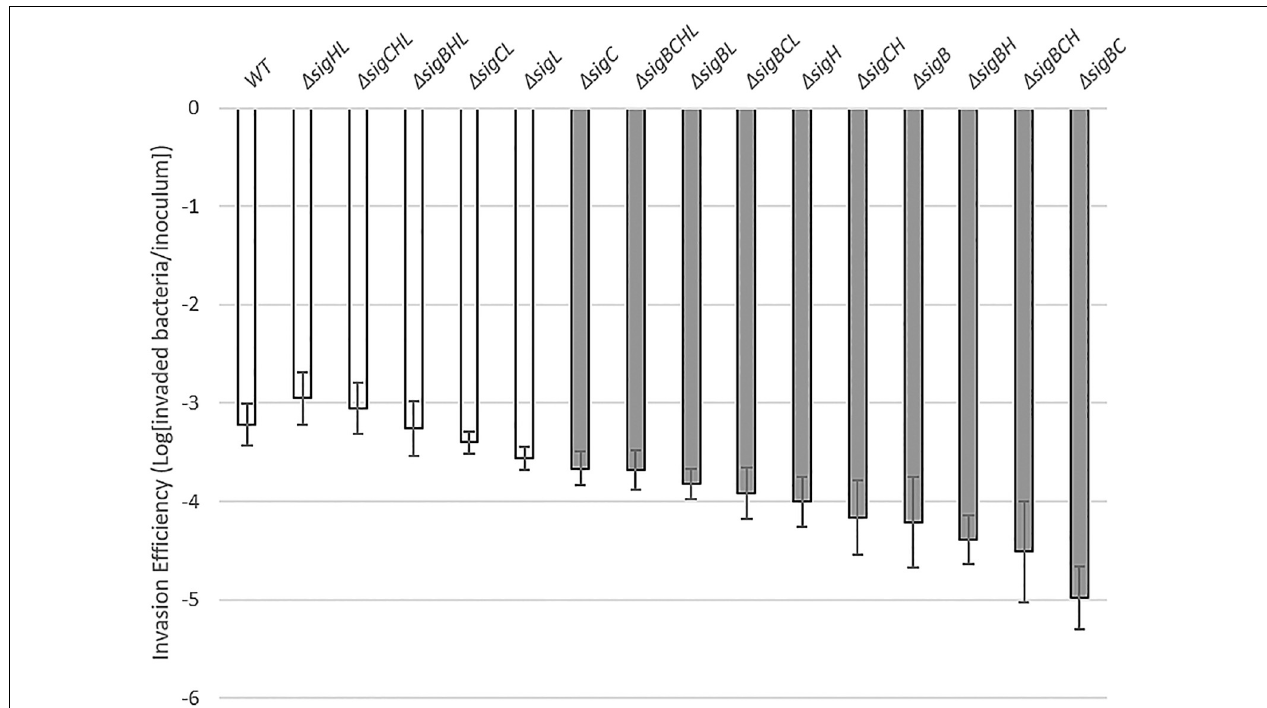
FIGURE 1 | Caco-2 invasion by 16 Listeria monocytogenes strains. A invasion efficiency of each strain ( X -axis) is shown in the log difference between invaded bacteria and inoculum of the corresponding strain ( Y -axis). Experiments were performed in three biological replicates with two technical replicates each. The dark gray bar indicates a significant difference from WT based on one-way ANOVA with Dunnett’s post-hoc test at p ≤ 0.05. The white bar indicates a similar level of invasion efficiency as in